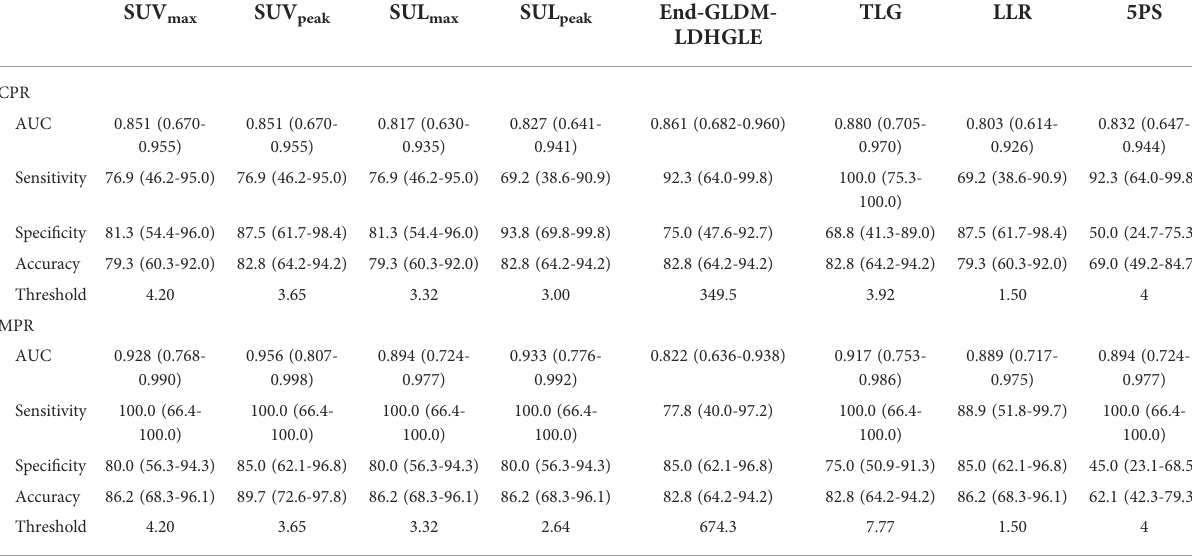
TABLE 6 Discrimination for predicting pathological response using different criteria.